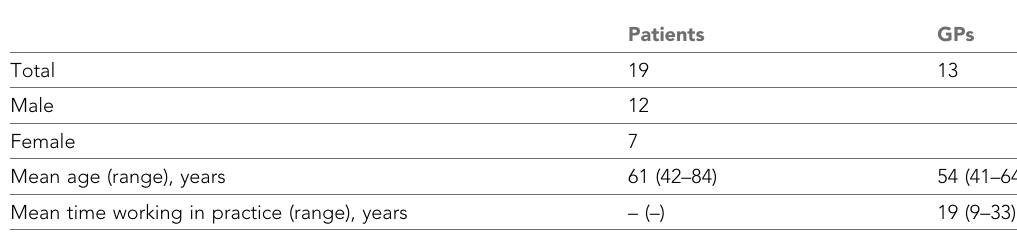
Table 1. Participants